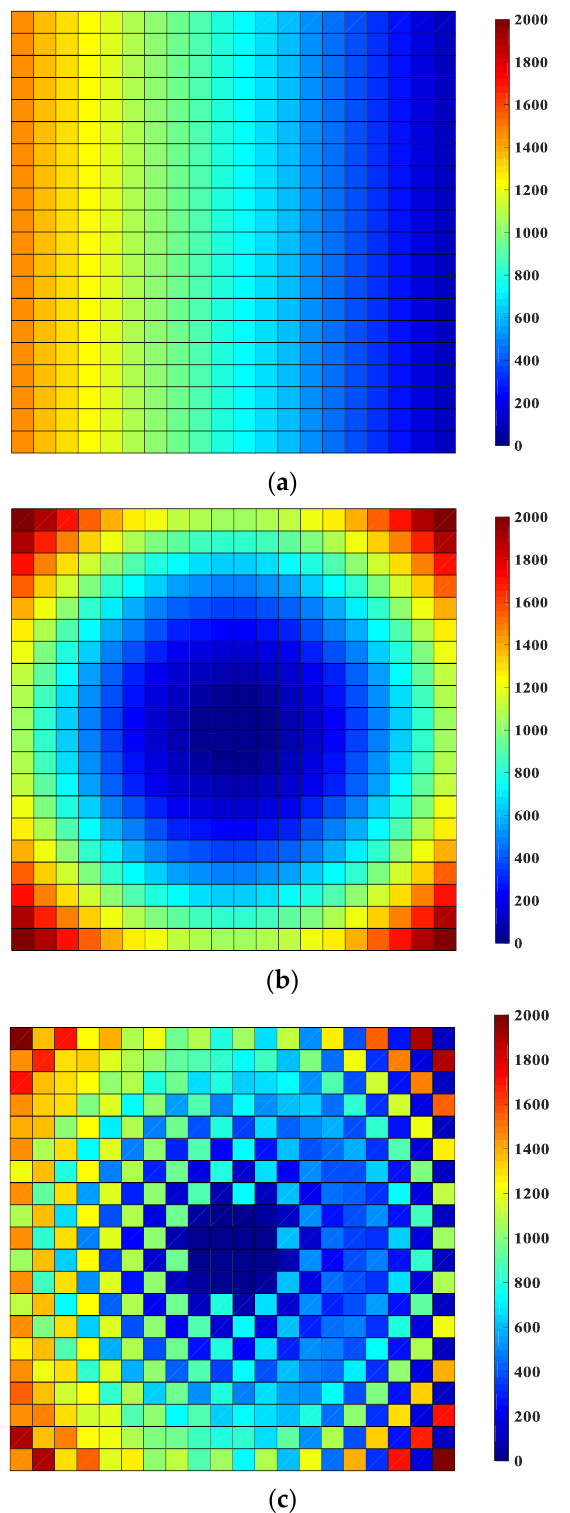
Figure 4. Full-wave simulated transmission phases of anisotropic surface. ( a ) Beam forming of 30 degrees ( b ) Beam focusing (Focal length = 60 mm) ( c ) Simultaneous beam forming and focusing.